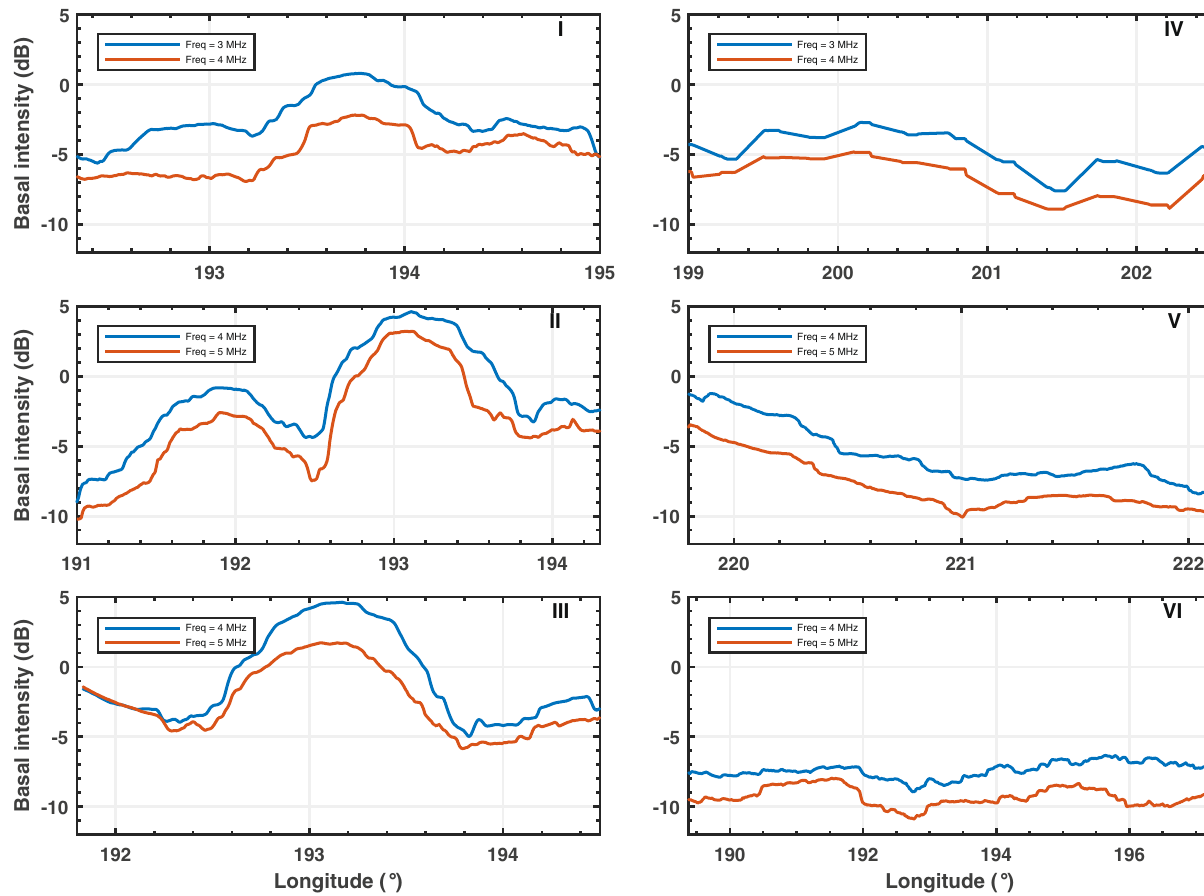
Fig. 2 | Basal normalized echo power measured at two frequencies. The plots refer to observations collected very close (I) or inside (II, III) and outside the main brightarea(IV,V,VI)ofFig.1,afterapplyinganalongtrackaverage 2 .Notethatplots IIandIIIdonottotallyoverlapandstart/endatdifferentlocations.Thedifferencein